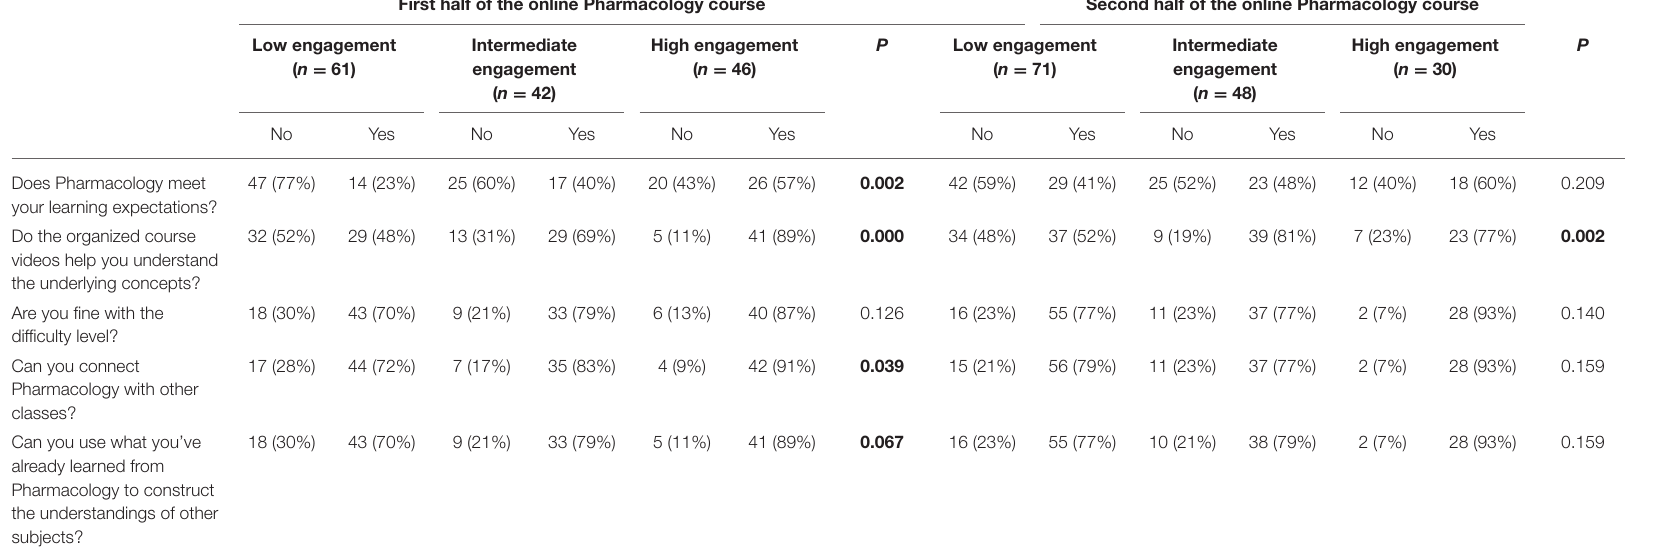
TABLE 3 | Analytic results of questionnaires on learning efficacy and